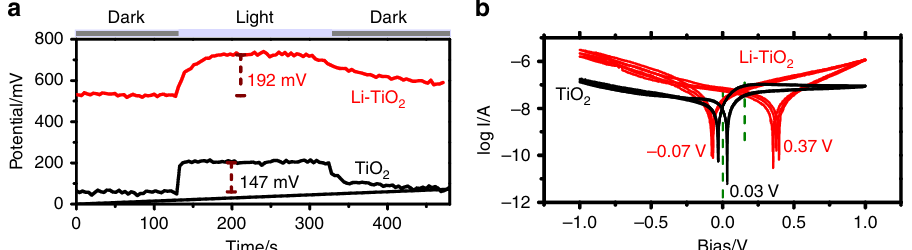
Fig. 5 Changes of charge separation and transfer for the TiO2 electrode upon lithiation. a Surface potential of TiO 2 and Li-TiO 2 in dark and under light illumination (380 nm) measured by KPFM. b Electronic conductivity measured by Cycle voltammetry (CV) scanning at the rate of 50 mV s − 1 for three circles. The log I – V curves instead of I – V curves are plotted for TiO 2 (black) and Li-TiO 2 (red). Green dotted lines represent the symmetric V i of TiO 2 (left) and Li-TiO 2 (right),